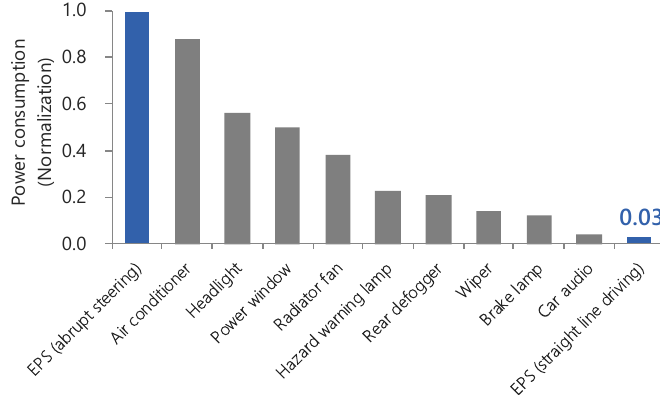
Figure 1. Measuring result of maximum electric power consumption of various electrical components of vehicle.